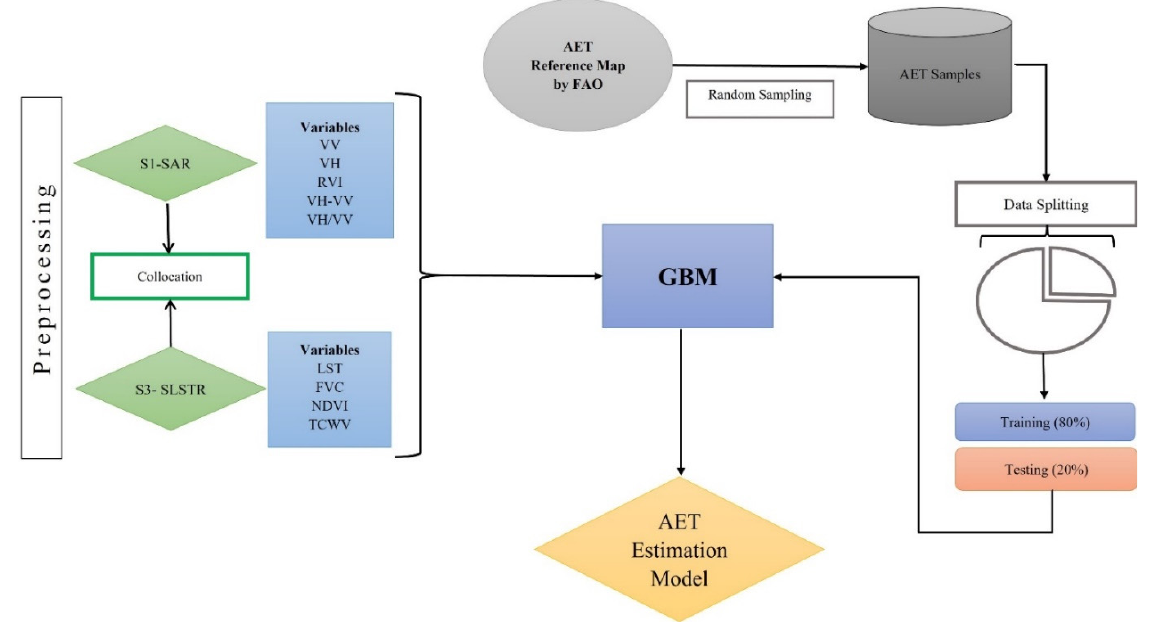
Figure 2. Flow chart of the study . Table 1. Variables used in the study and their descriptions.